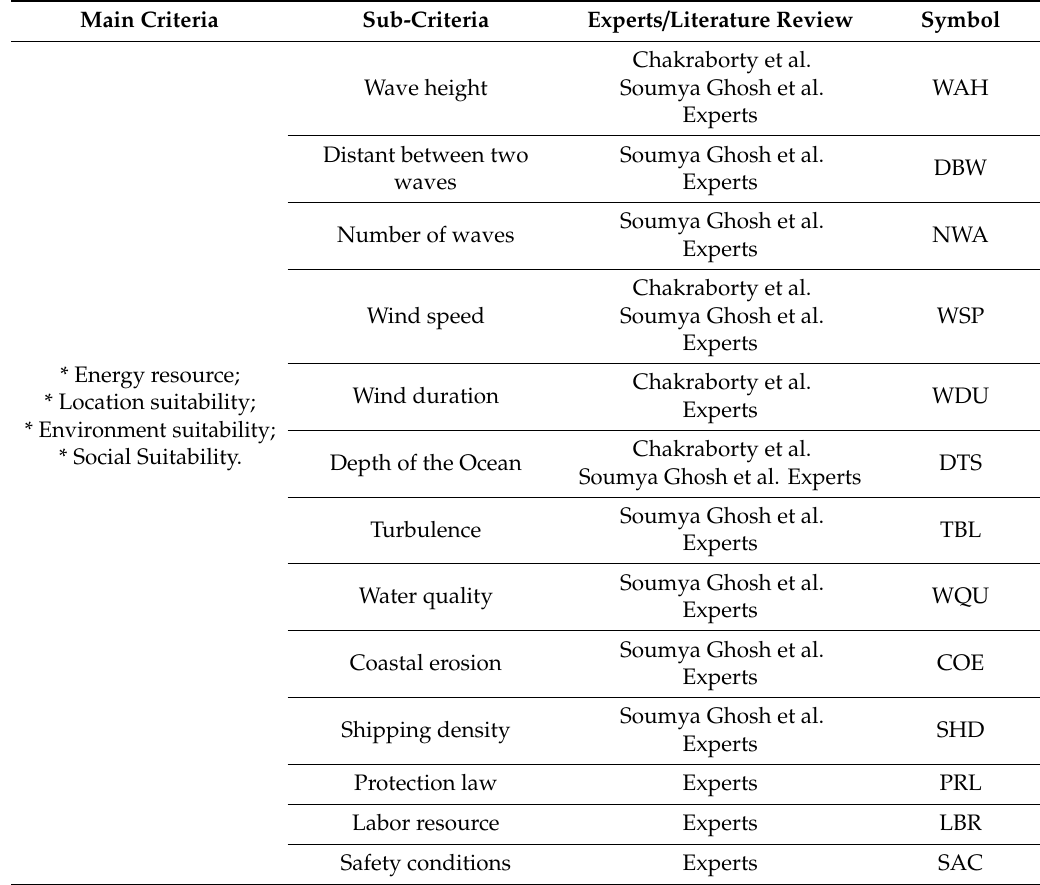
Table 3. The hierarchy of the objectives.